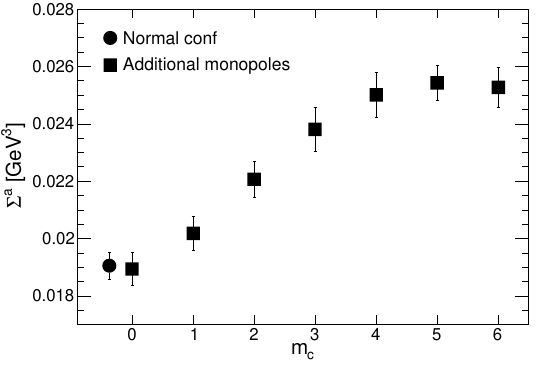
Figure 9 . The scale parameter (cid:6) a versus the magnetic charges m c . The results of (cid:6) a are the average values in table